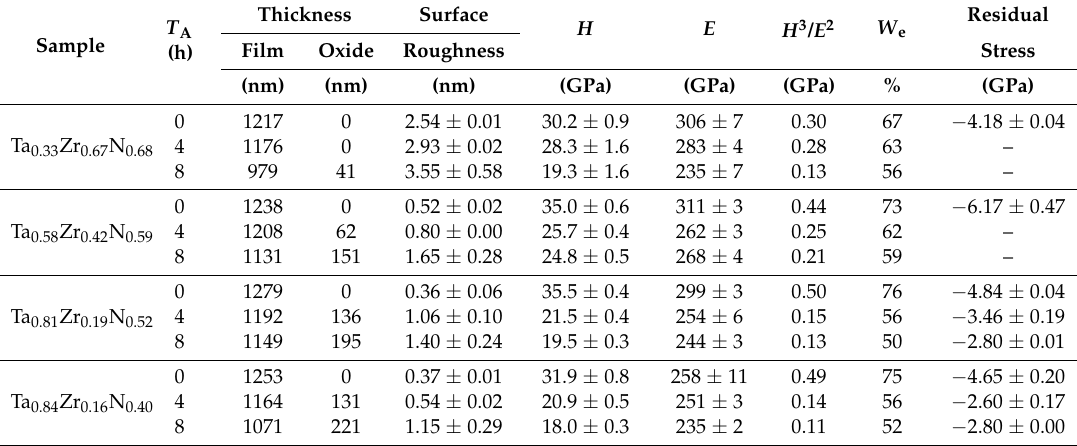
Table 3. Film and oxide scale thicknesses, surface roughness, mechanical properties, elastic recovery, and residual stress values of as-deposited and 600 ◦ C-annealed Ta–Zr–N thin films prepared on Si